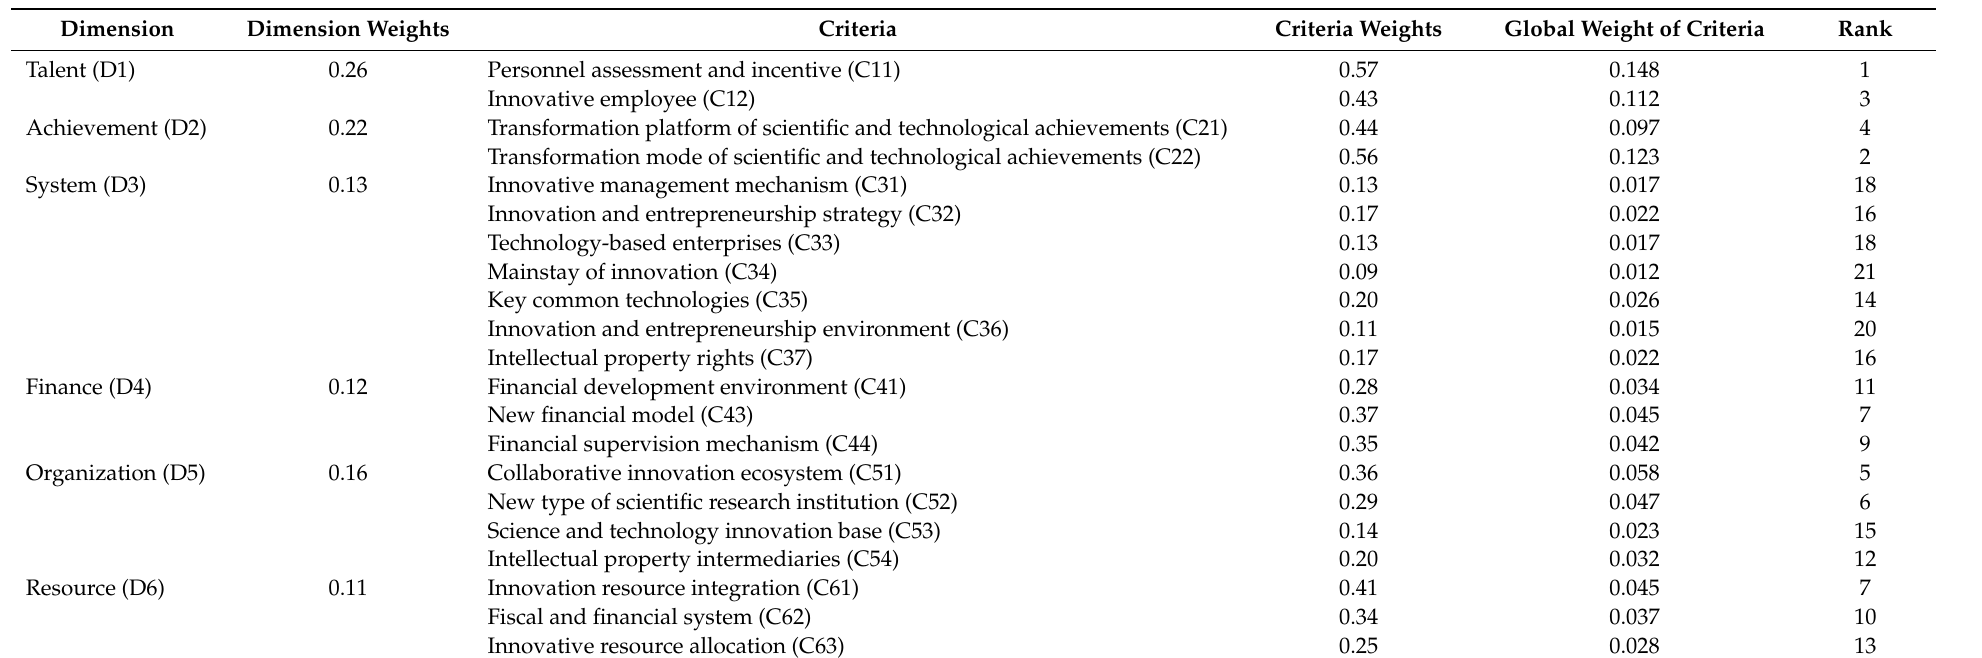
Table 15. Local and global weight of dimensions and